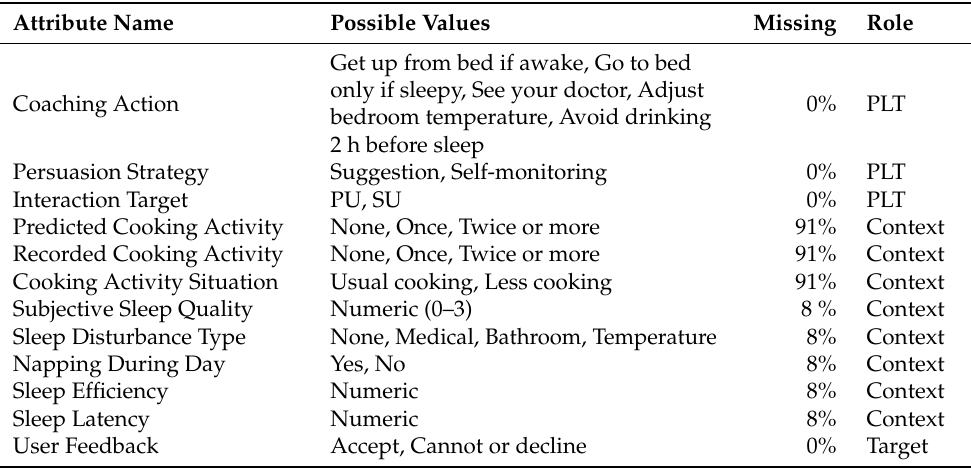
Table 1. Attributes of the sleep quality coaching dataset comprised of 324 issued coaching actions, some of the context attributes in the collected data set have missing